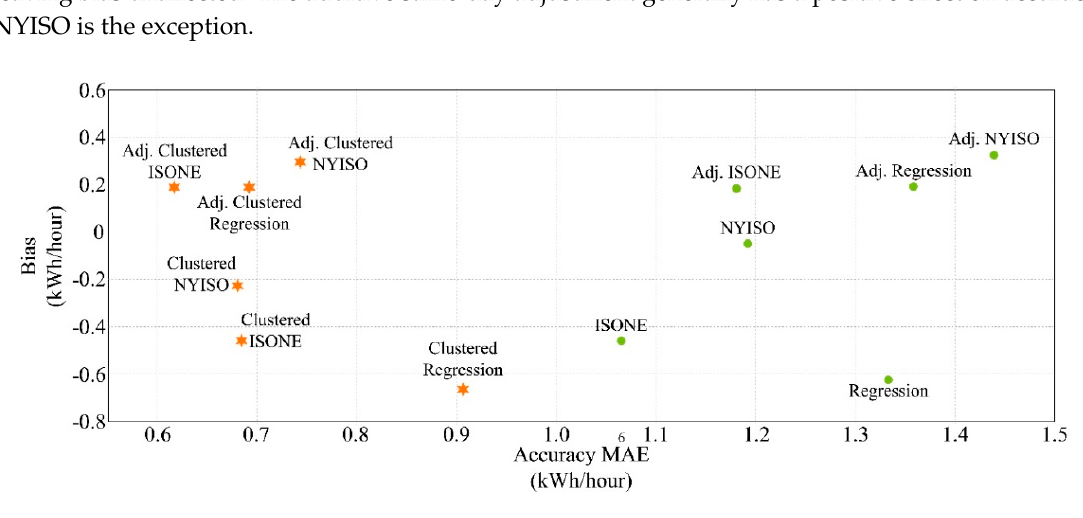
Table 5. Error analysis before load aggregation.